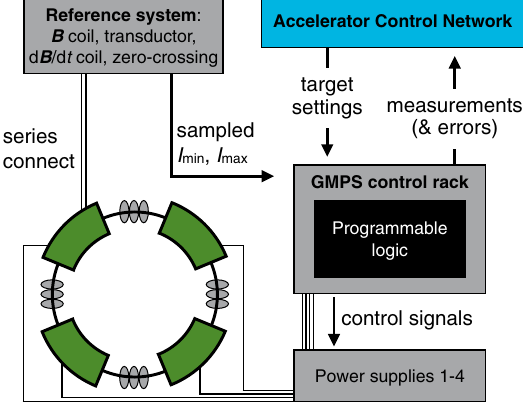
FIG. 1. Schematic view of the GMPS control environment. The human operator specifies a target program via the Accelerator Control Network that is transmitted to the GMPS control board. The FPGA-based control logic utilizes these settings together with readings from a reference magnet to prescribe a driving signal to the GMPS. The effect of this prescribed signal on the bending magnets is measured by an in-series reference magnet, with sampled readings transmitted back to the GMPS control board. Reference measurements and prescribed signals may be logged and transmitted over the network for later